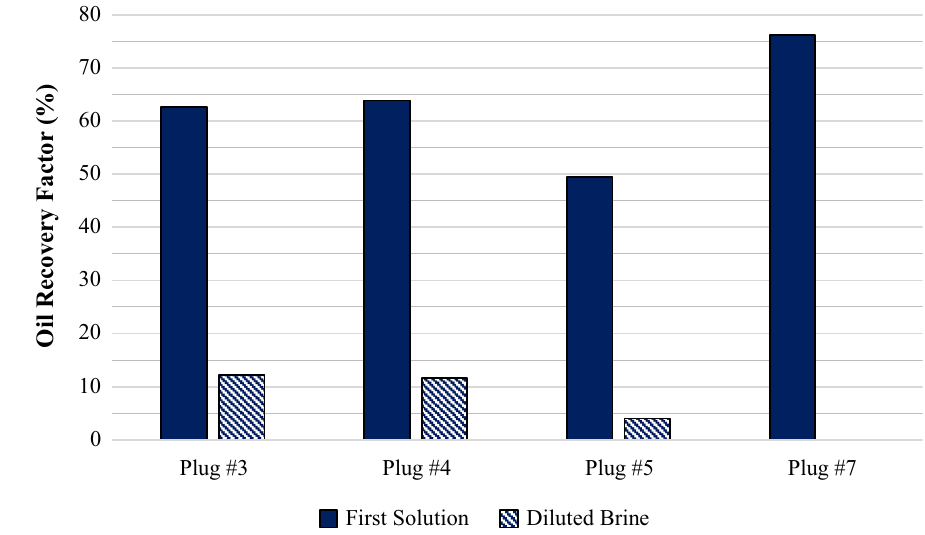
would make the surface more water-wet and incremental oil recovery is expected. As it has been pointed out ear- lier, by injecting low-saline brine, higher pressure drop was observed. For example, in the case of test #4, the pressure difference (DP) during the sea water injection was observed to be 29.9 psi, while for 10-times diluted sea water a value of 37.8 psi was recorded as the maximum pressure difference.